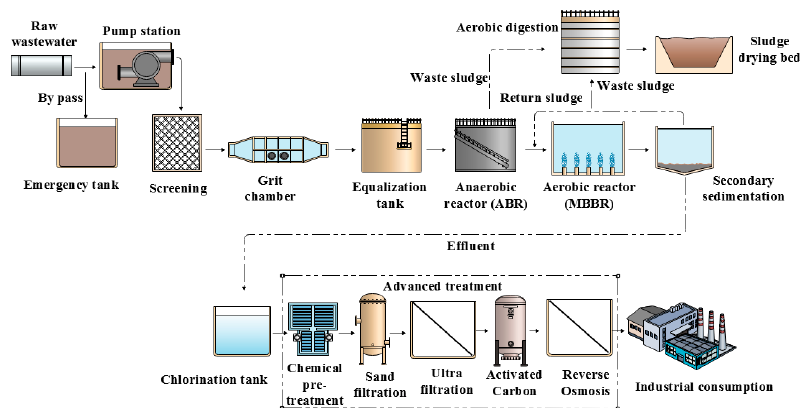
Figure 4. The geographic location of MIC WWTP.